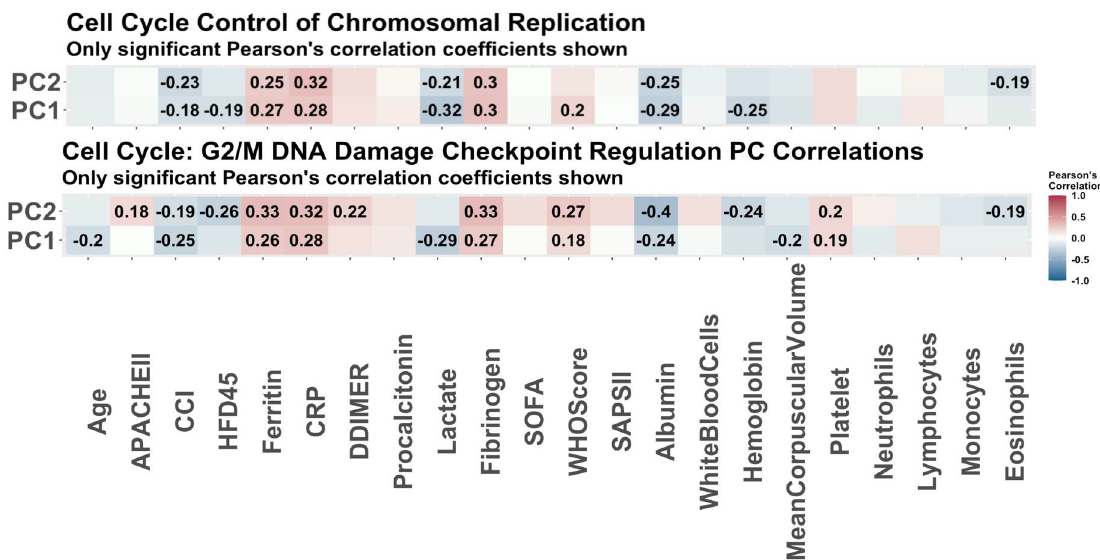
Fig 1. The Pearson correlations of principal components of pathways associated with disease status. The Pearson correlations of clinical variables and principal components used to summarize the enriched pathways in COVID-19 as predicted by IPA. These are the pathways predicted to be enriched based on 16 genes determined to be associated with COVID-19 via stability selection. Only the correlations which were significant (p-value < 0.05) are reported. Some of the strongest correlations are with ferritin, CRP, and lactate.